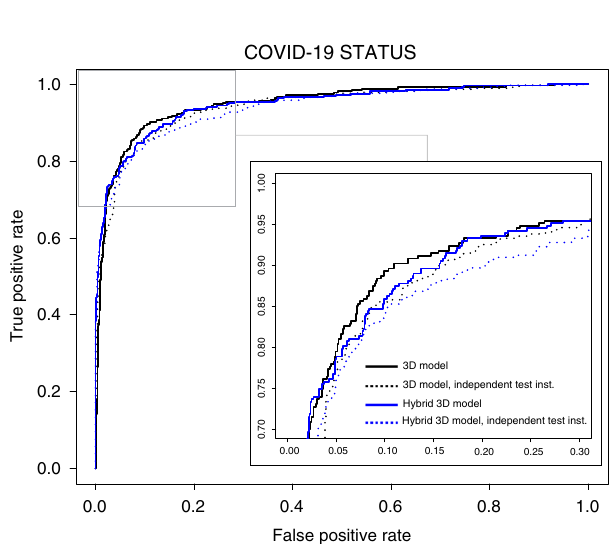
Fig. 2 Model performance. Receiver operating characteristic (ROC) curve for 3D and hybrid 3D classi fi cation models. Both experimental conditions are shown, with highlighted area to zoom in at upper left area of the curve. Solid lines represent original training design, dotted lines indicate independent testing population